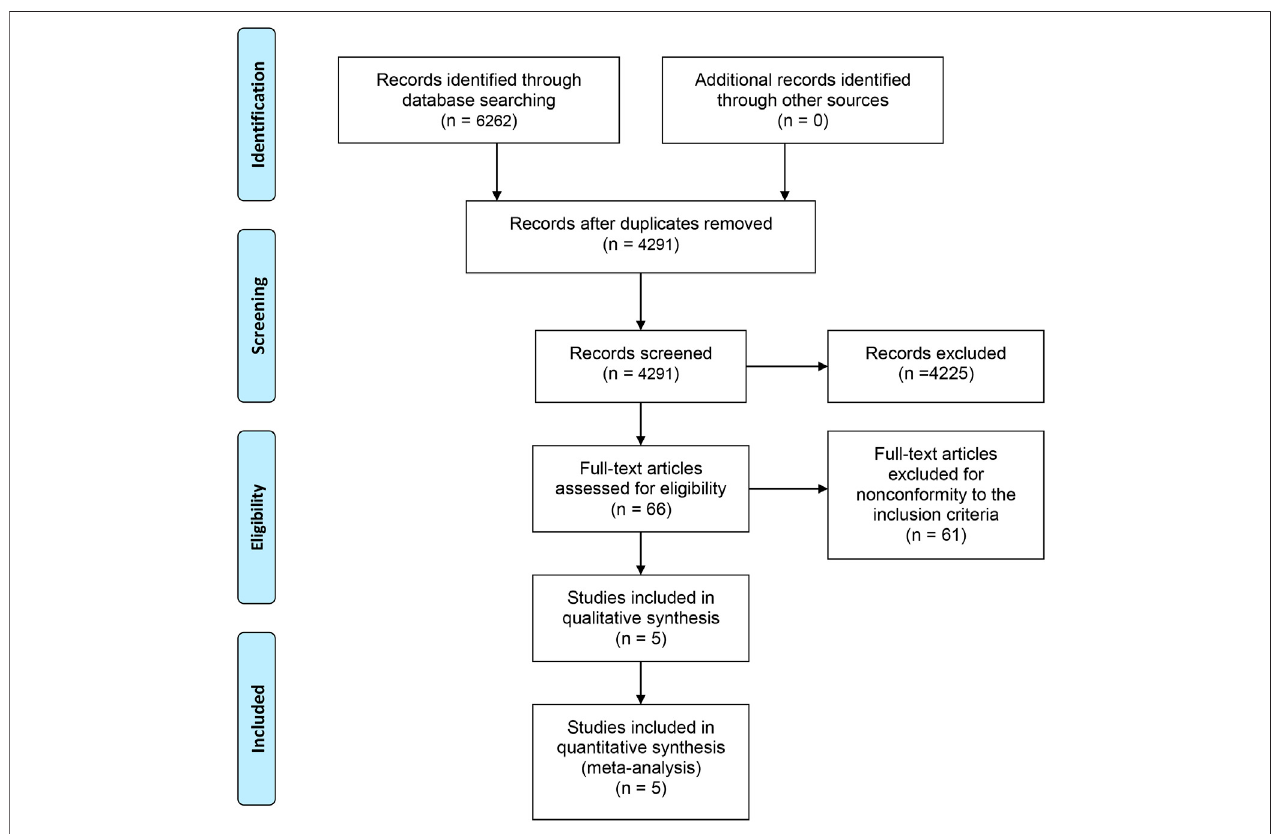
FIGURE 1 | PRISMA fl owchart of study selection.